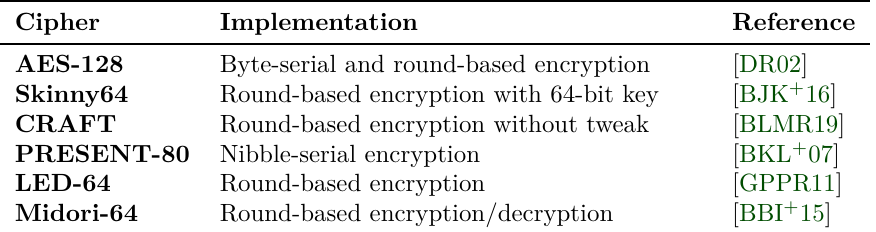
Table 2: Full cipher implementation case